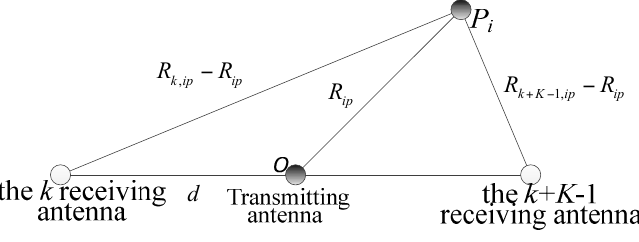
Figure 3. The relationship geometry between the i -th scattering center and the k -th receiving antenna, the k + K ´ 1 receiving antenna and the transmitting antenna at time t p